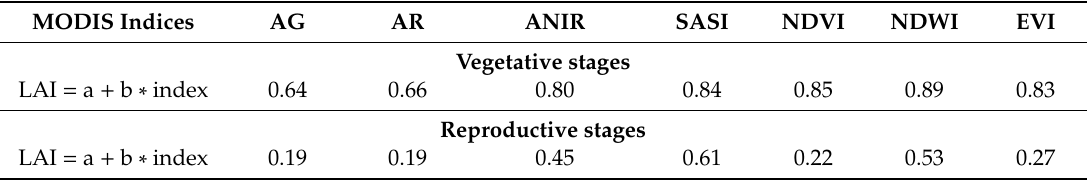
Table 4. Coe ffi cients of determination (R adj2 ) of a linear regression model for both years between LAI and MODIS spectral indices (LAI = a + b ∗ Index) for the vegetative ( n = 22) and the reproductive stages ( n = 18) in a rainfed barley ( Hordeum vulgare L.) in Madrid, Spain. MODIS Indices AG AR ANIR SASI NDVI NDWI EVI Vegetative stages LAI = a + b ∗ index 0.64 0.66 0.80